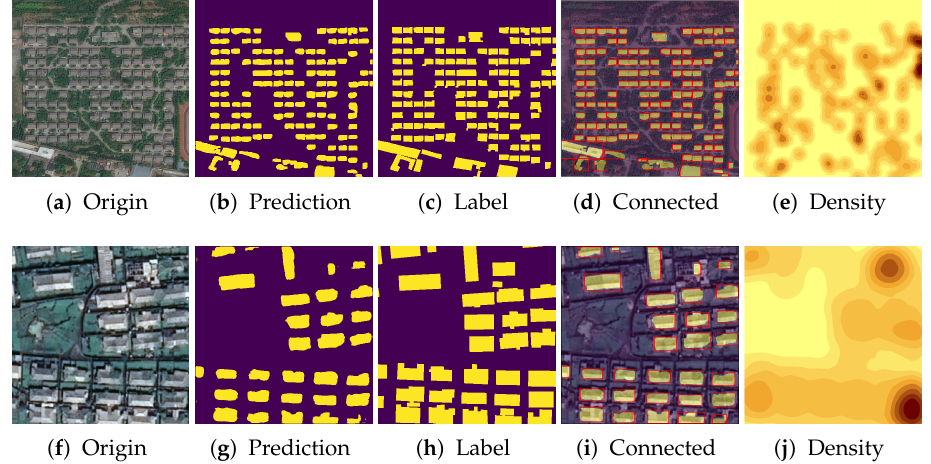
Figure 7. The overall building information extraction effect in both datasets.